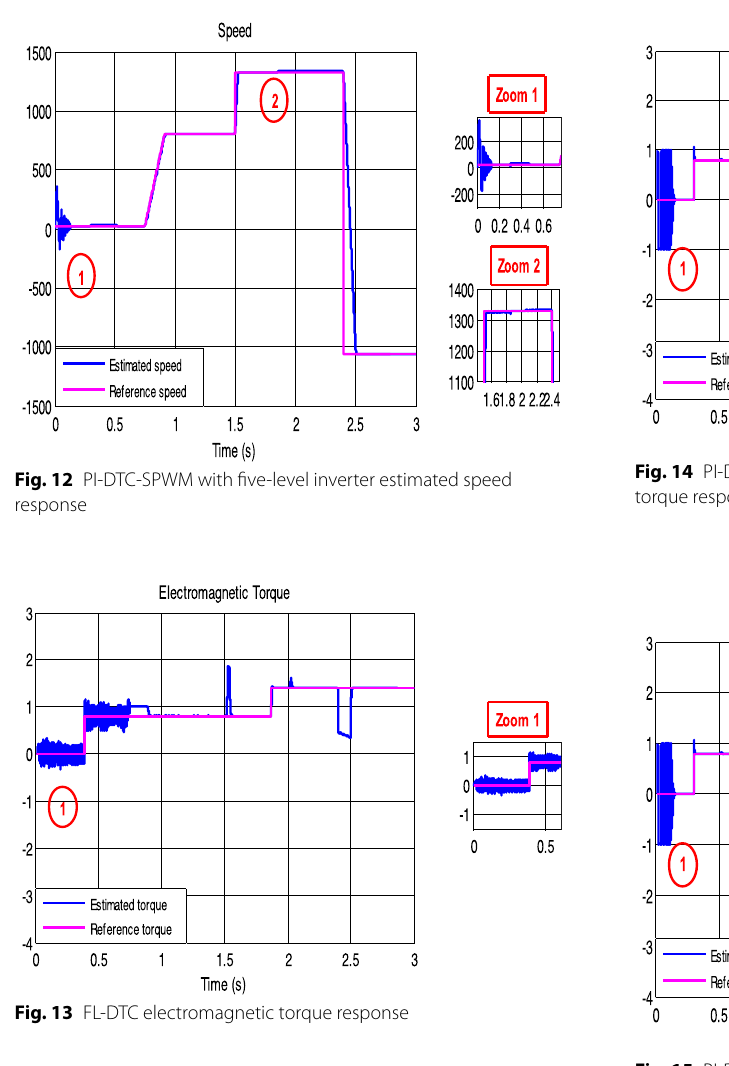
Fig. 15 PI-DTC-SPWM with five-level inverter electromagnetic torque